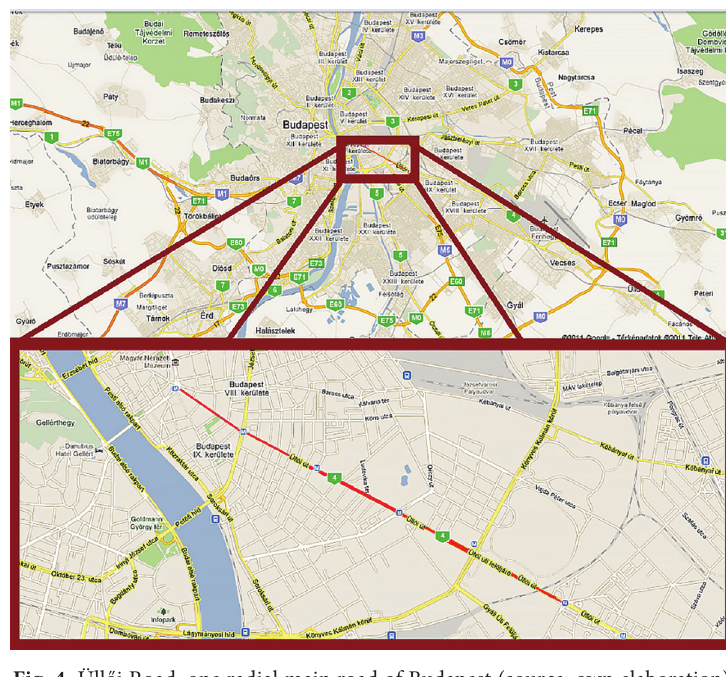
Fig. 4. Üllői Road, one radial main road of Budapest (source: own elaboration)